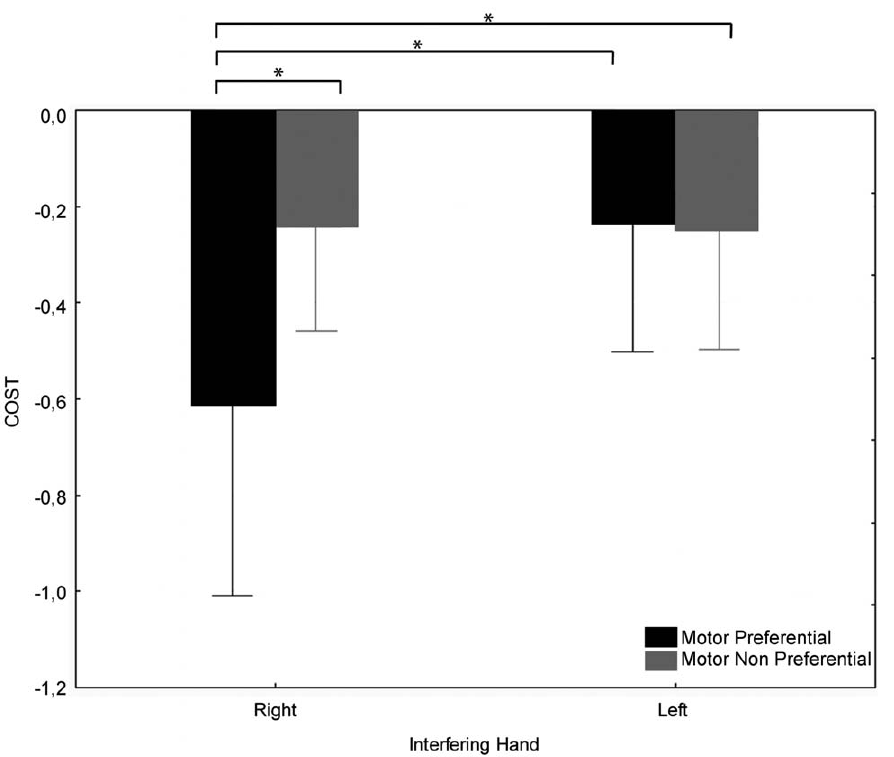
Figure 3. Cost of the motor interfering task as a function of the interfering Hand (Right or Left) for the two categories of ellipses (Motor Preferential or Motor Non-preferential). Error bars represent the 95% confidence intervals.